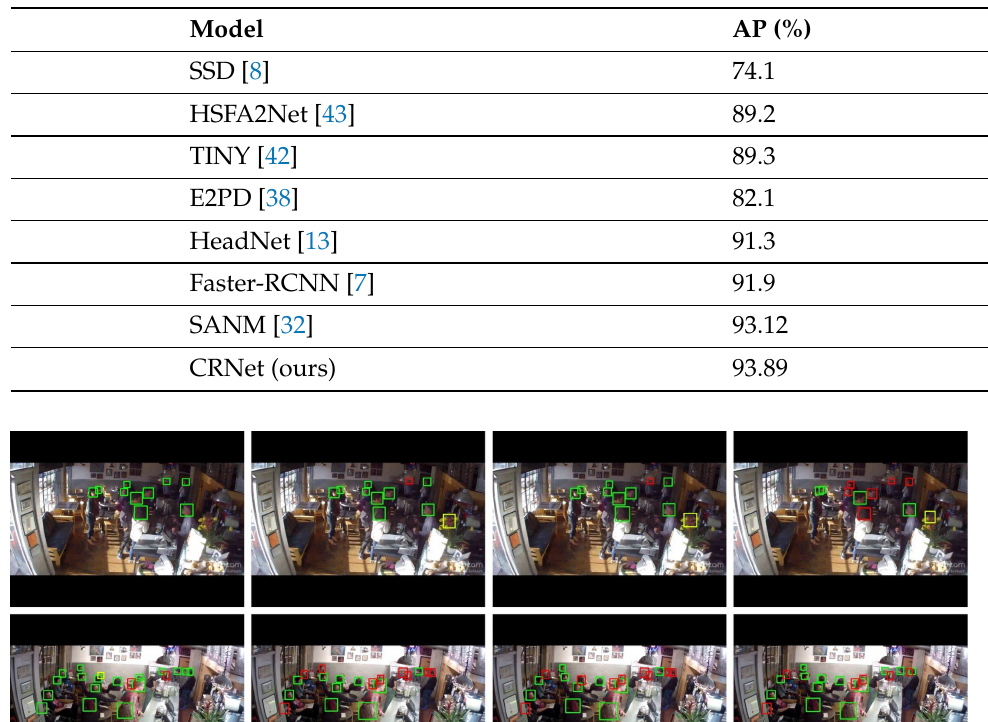
Table 4. The results on the Brainwash dataset.